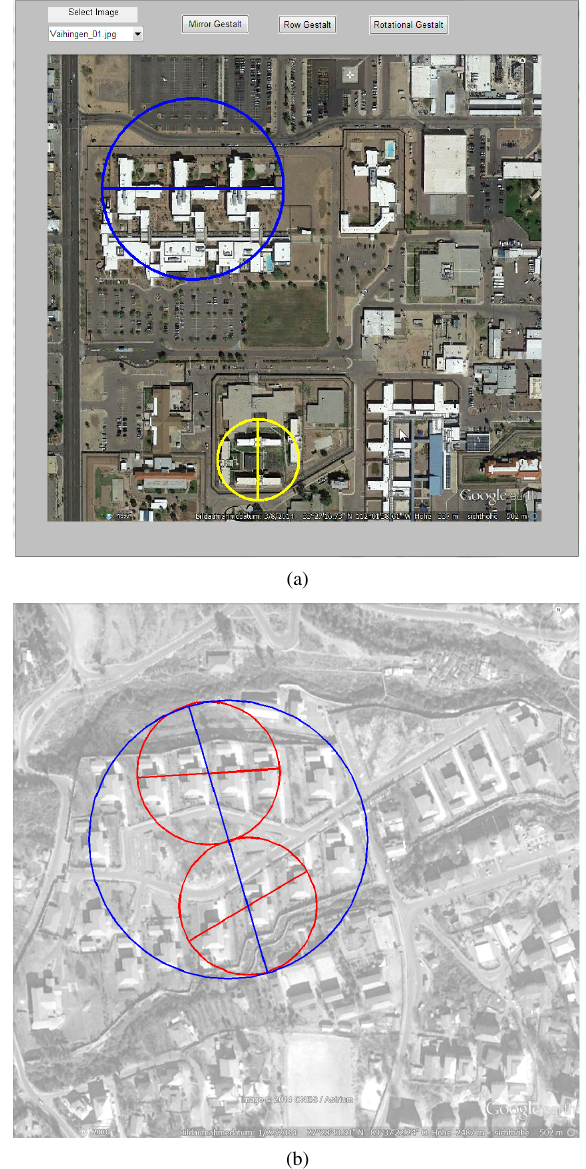
Figure 1: (a) GUI for ground-truth acquisition: Salient row- Gestalt in blue, salient mirror-Gestalt in yellow. (b) Some result on image #11: Salient mirror-symmetry-Gestalt in blue, it’s part row-Gestalten in